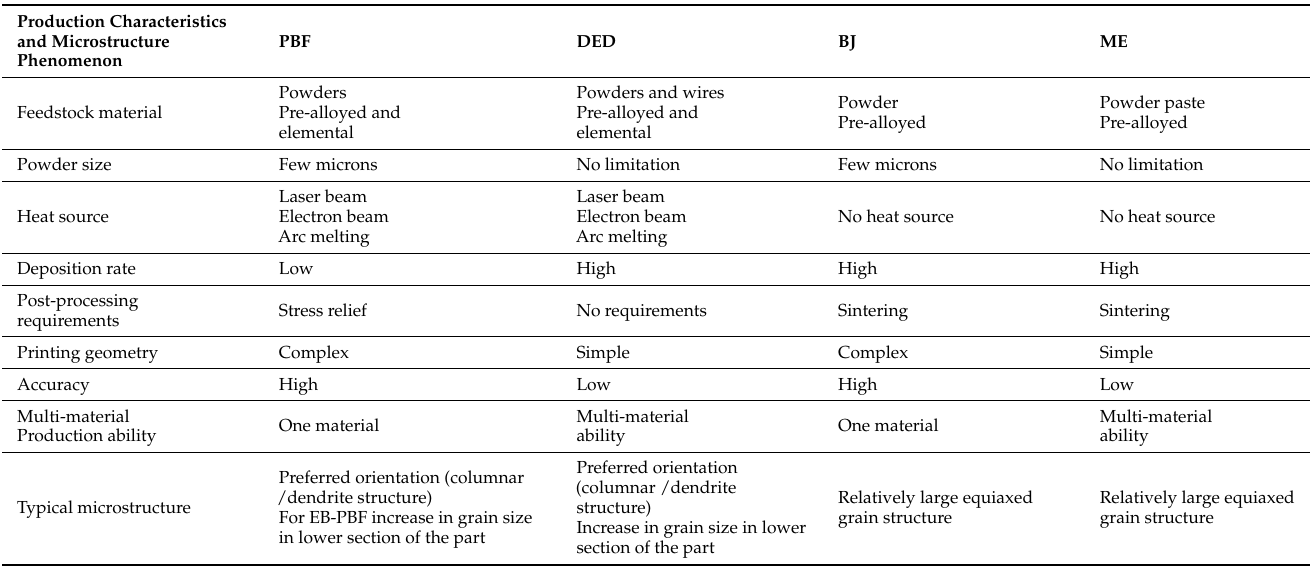
Table 12. Comparison of production characteristics and microstructure phenomena of different AM processes used to produce HEAs.